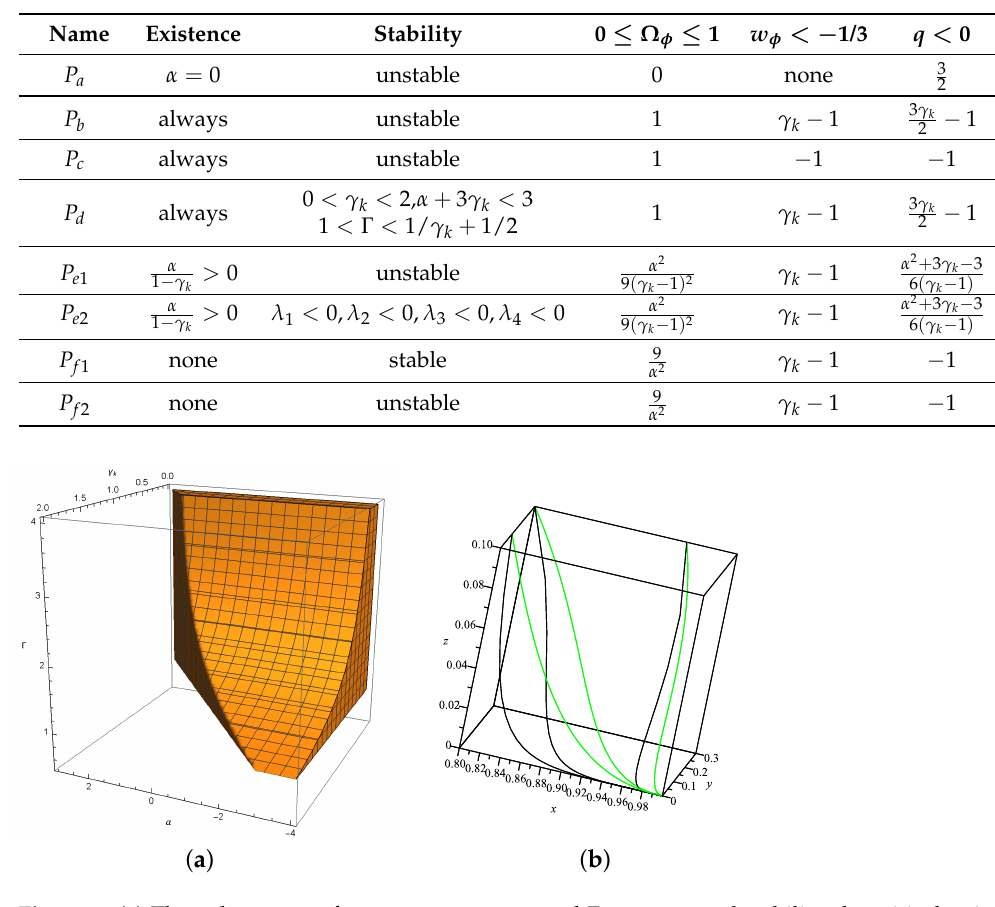
and Γ = 11 , corresponding to two different values 7 10 ) 7